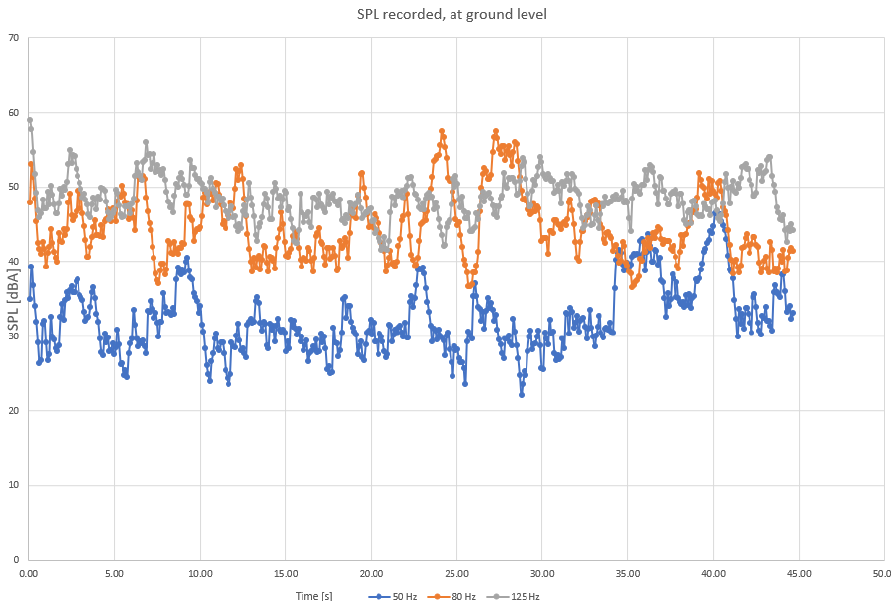
Figure 4. SPL variation recorded in lower frequency range (50 Hz, 80 Hz, and 125 Hz traffic noise), ground level: blue—50 Hz, orange—80 Hz, and grey—125